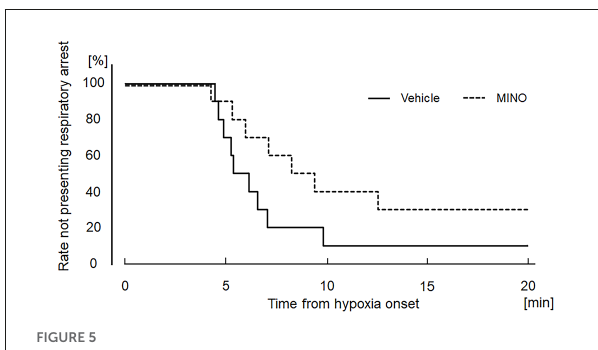
FIGURE5 Kaplan − Meier curves showing the time from hypoxia onset to respiratory arrest in the vehicle (saline) and minocycline pre-treated mice; 10 mice each. There were no significant differences between the two groups. MINO,